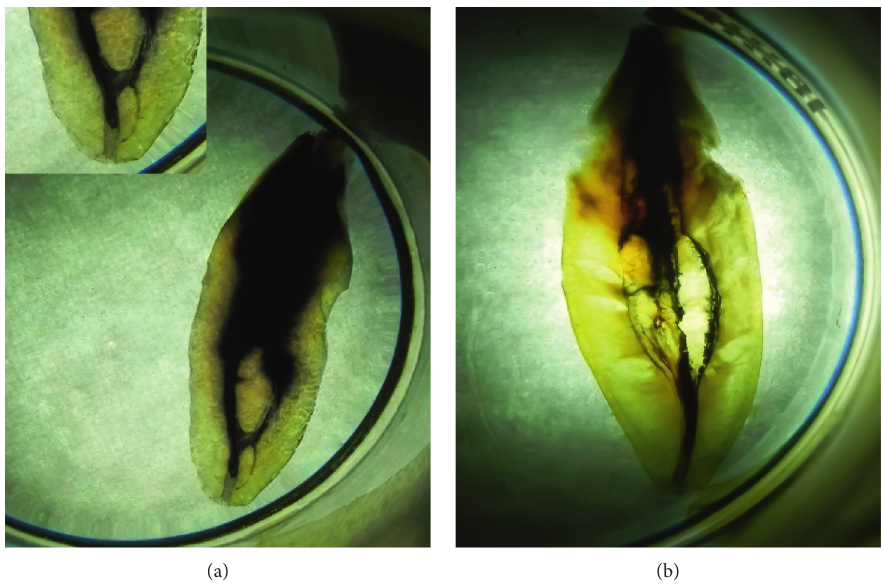
Figure 3: Loop in the position of accessory canal and 2-3-1 canal